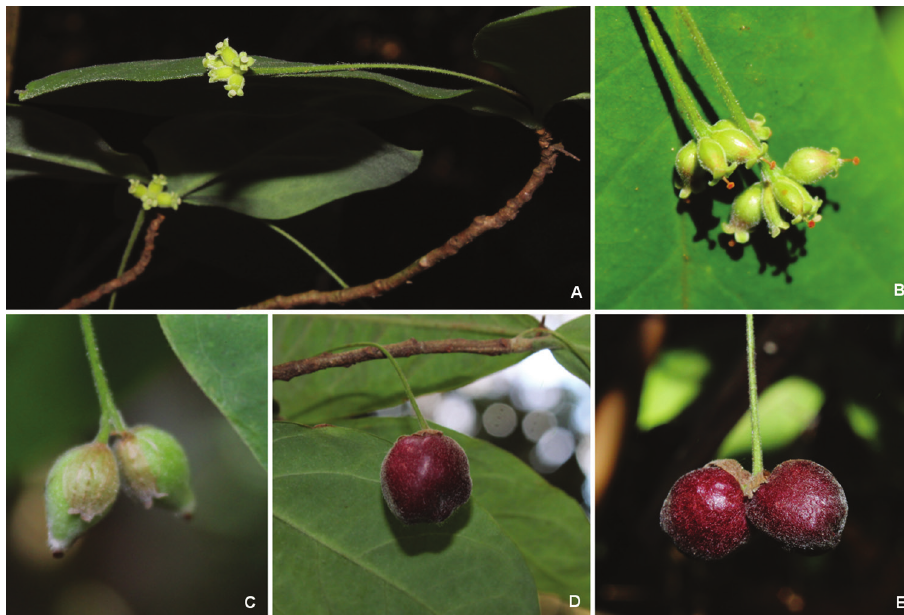
Figure 2. Daphnopsis filipedunculata Nevling & Barringer. A pistillate flowering branch B detail of inflorescence with pistillate flowers C immature fruit with persistent hypanthium D, E mature fruits. Photographs by Fernando M.